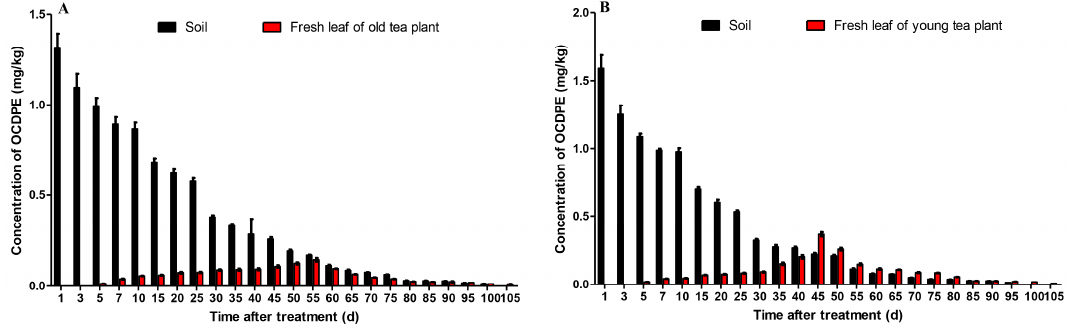
Figure 2. Migration and accumulation of OCDPE in soil-tea systems (n = 3). ( A ) Fresh leaf samples of old tea plants; ( B ) fresh leaf samples of young tea plants.